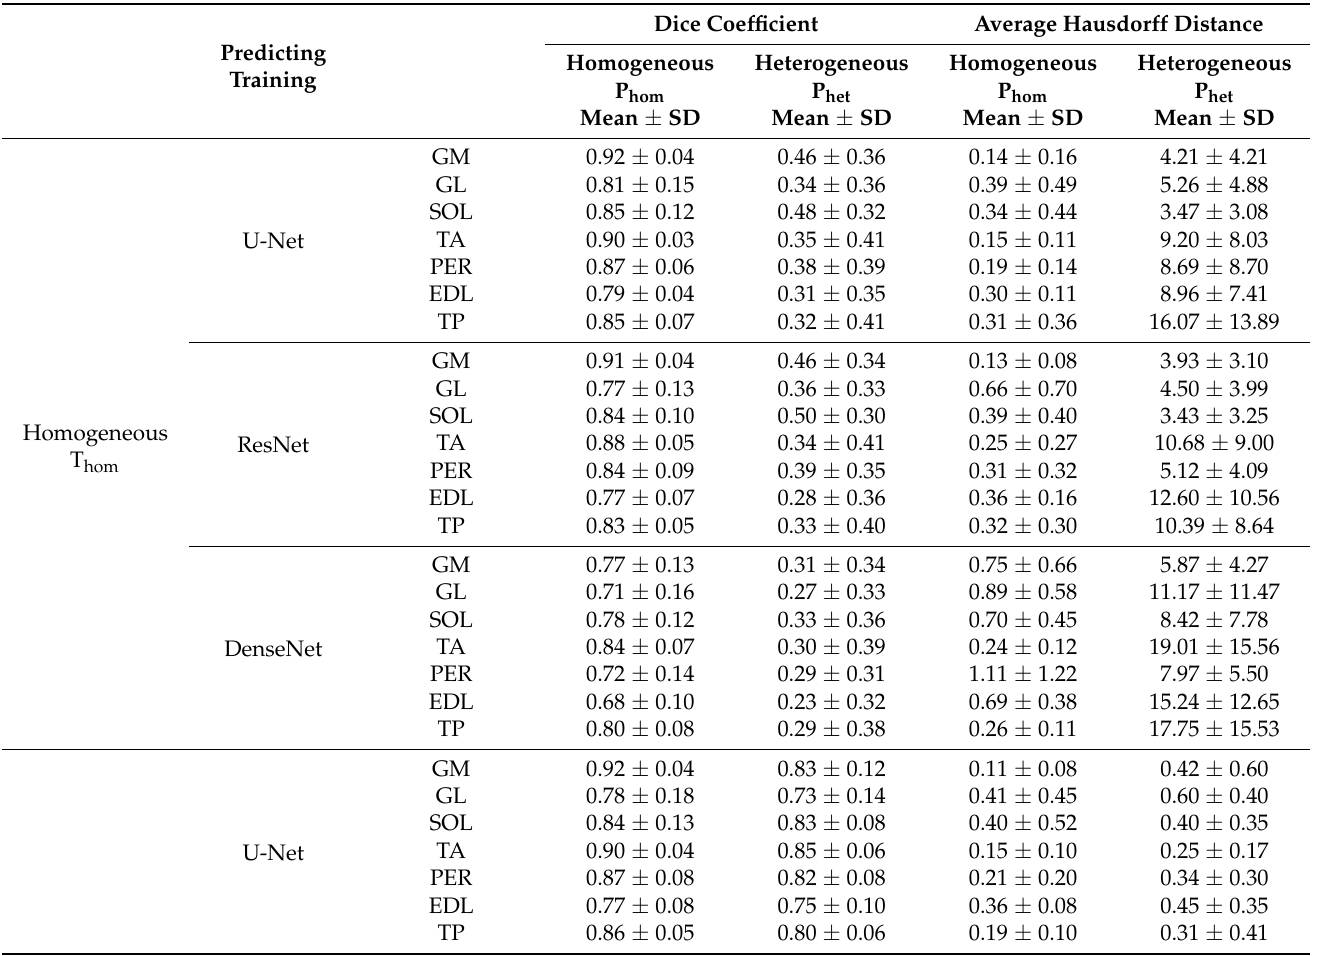
Table A1. Overview of mean Dice score and average Hausdorff distance calculated by muscle.